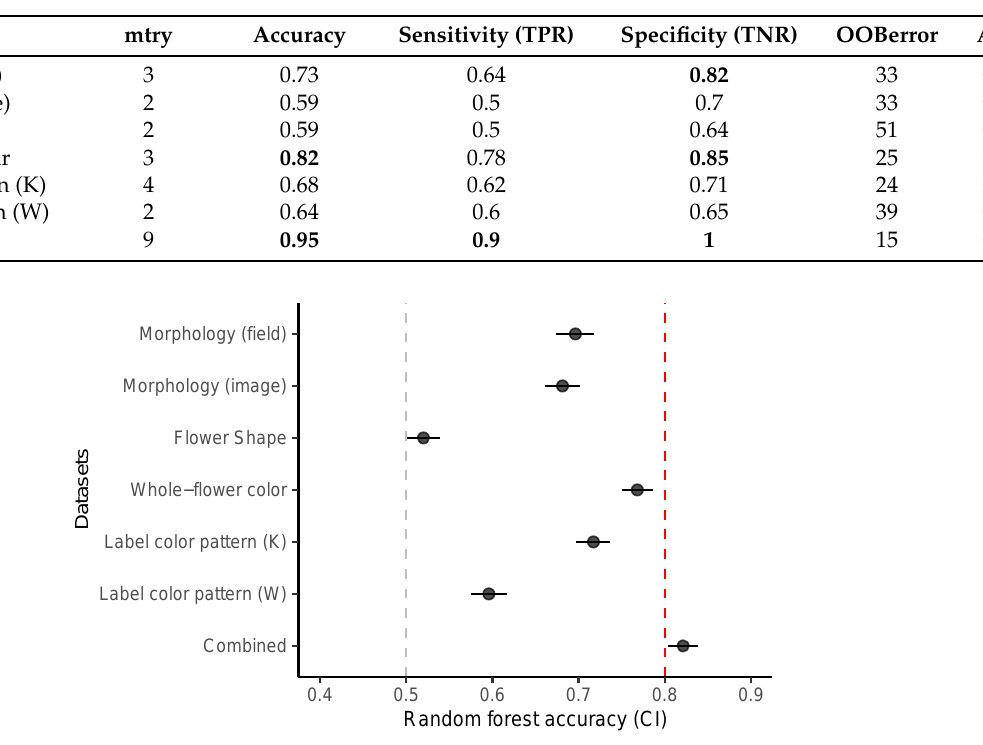
Table 1. Performance indices of random forest models for each dataset and for a combined dataset. OOB error = out-of-bag error, sensitivity = true positive rate (TPR) with O. a. aveyronensis as the positive class, specificity = true negative rate (TNP) with O. a. vitorica as the negative class, and AUC = area under the curve. All random forests were trained (using 80% of the data) and tested (using 20% of the data) on the same individuals.